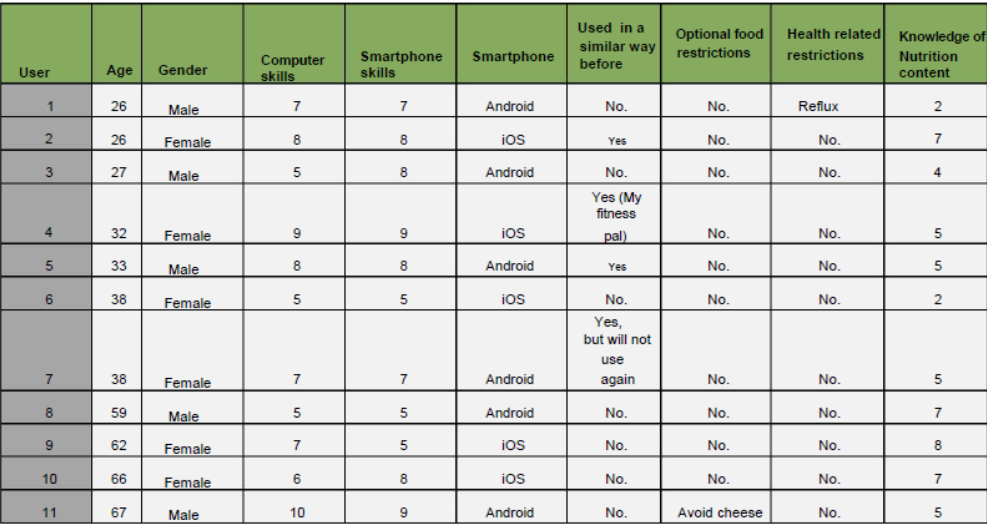
Figure 2. Respondent